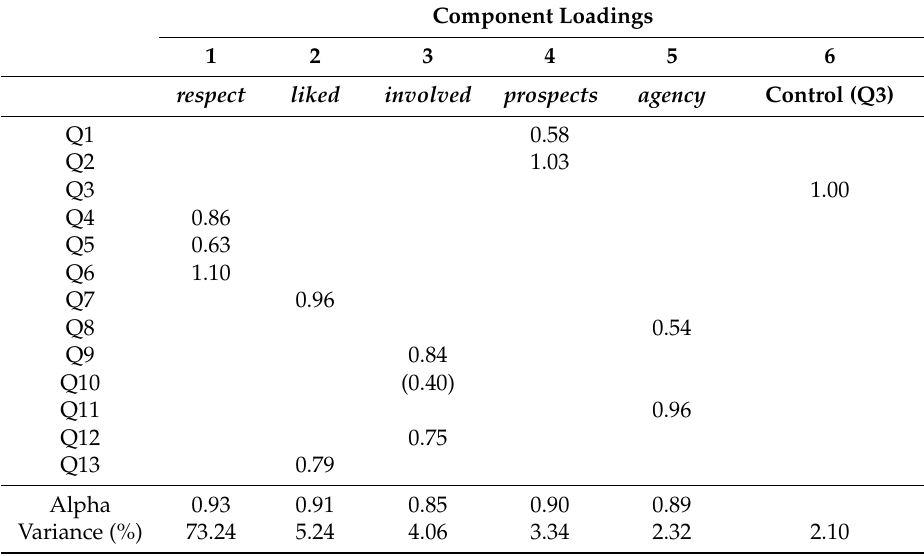
Table 4. Pattern matrix (loadings > 0.5) resulting from exploratory factor analysis (six components). Cronbach’s Alpha and percentage of variance is included. The control question (Q3) represents a sixth